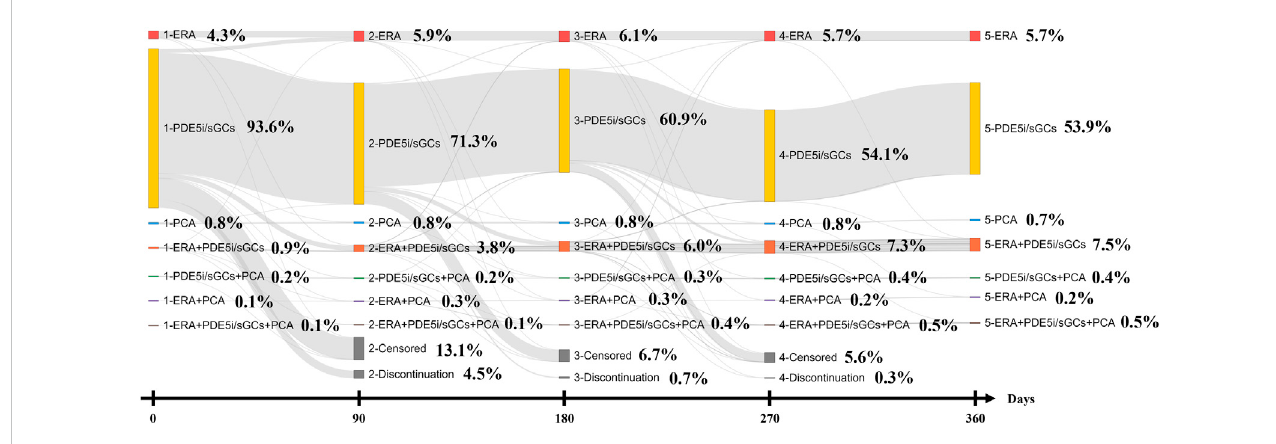
FIGURE 2 Treatment patterns of Sankey diagram (The 90 days interval for Sankey diagram was based on the grace period. Day 0 indicates the initial/index treatment. Day 90, 290, 270 indicates the fi rst regimen within 90 – 179, 180 – 269, and 270 – 359 days after the index date).